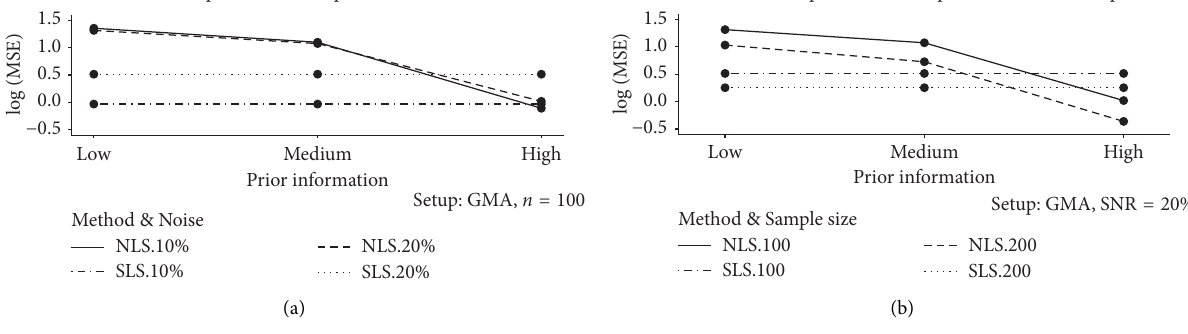
Figure 1: The plot gives MSEs on a log scale (computed as averages over Monte-Carlo simulation runs) for linear parameters plotted against the quality of prior information. In panel (a), the comparison is on the basis of the noise level. The graph indicates that the performance of NLS worsens with decreasing quality of prior information. On the other hand, the performance of SLS is not affected by the quality of prior information, in agreement with the experimental design. Except for the rare case of high-quality prior information, where NLS is better, SLS clearly outperforms NLS. In panel (b), the comparison is based on the sample size. The overall pattern is similar to that in panel (a).